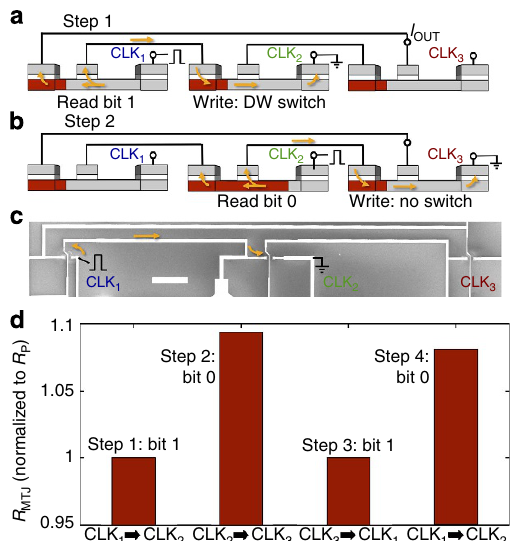
Figure 5 | Three inverters circuit. ( a ) Cartoon showing three devices connected in series, with the output of device 3 feeding back into the input of device 1. The devices are initialized with their domain walls (DWs) on the left and the tunnel junctions parallel. In the experiment, at Step 1 we apply a voltage pulse at CLK 1 to read the state of device 1 while writing the state of device 2. The voltage pulse is applied between CLK n and CLK n þ 1 . Yellow arrows represent electron flow direction. In this case the DW in device 2 switches. ( b ) Cartoon of Step 2, where we now apply a voltage pulse at CLK 2 to read the state of device 2 while writing the state of device 3. In this case the DW in device 3 does not switch. In Step 3 and Step 4 this is repeated at CLK 3 and CLK 1 , respectively. ( c ) SEM of three devices in series. R P1 ¼ 23.8 O , R P2 ¼ 19.0 O , and R P3 ¼ 18.4 O . Scale bar, 50 m m. ( d ) Plot of the MTJ resistance at each step in the three inverters circuit, showing the oscillation of the DW position at each step between the parallel (low MTJ resistance, bit 1) and antiparallel (high MTJ resistance, bit 0) device states. Figure 3b shows the reversibility behaviour of device 1. After initialization in the buffer configuration, at þ 2.9 V R MTJ switches low; reversing ^ H B we see R MTJ switch high again at (cid:3) 4.8 V. H B is higher on the negative side of the loop since the field direction is less parallel to the DW.